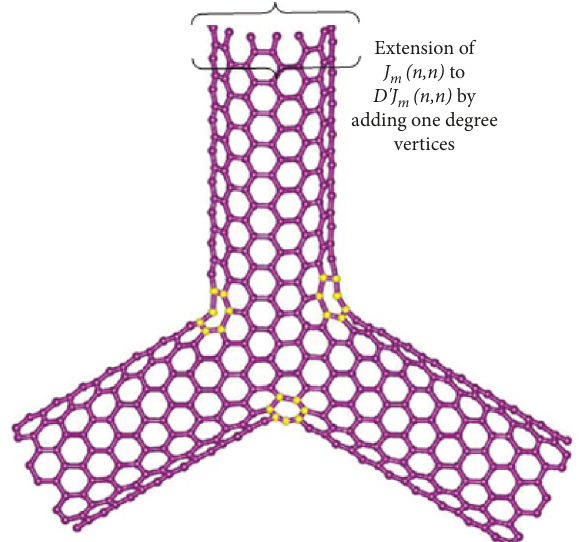
Figure 2: A variant of Y -junction